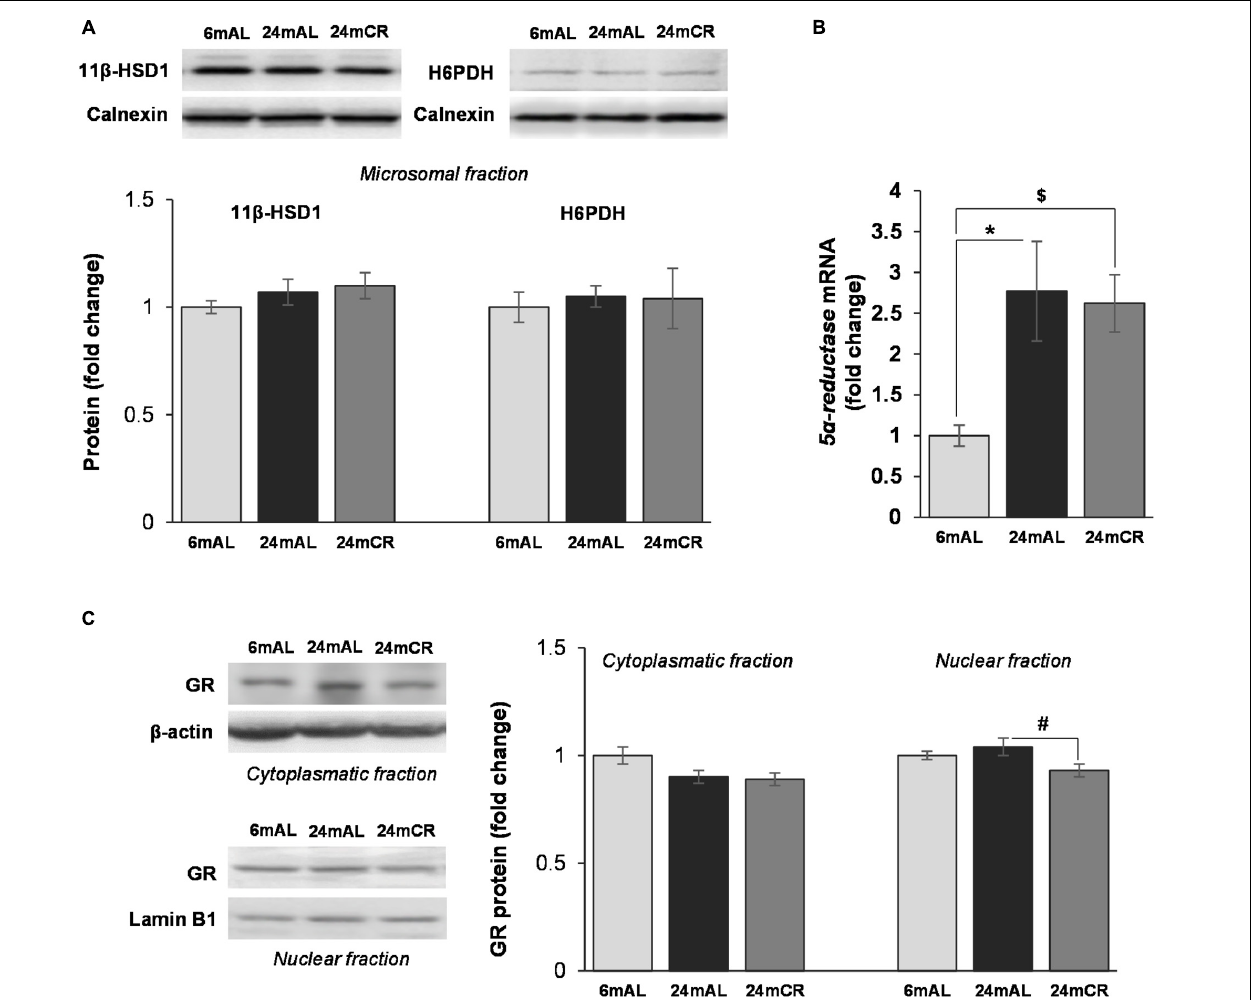
FIGURE 5 | Glucocorticoid prereceptor metabolism and GR protein level in the liver. Representative Western blots and relative quantification of 11 β -HSD1 and H6PDH protein levels in microsomal fraction (A) and GR protein levels in cytoplasmatic and nuclear fraction (C) of the liver of adults (6 mAL), aged rats on AL diet (24 mAL), and old rats on CR (24 mCR). Calnexin, β -actin and Lamin B1 were used as loading controls for microsomal, cytoplasmatic, and nuclear fraction, respectively. Quantification of 5 α -reductase mRNA (B) level in the liver was done relative to the amount of β -actin. All values are given as means ± SEM ( n = 8). Asterisk indicates significant difference between aged rats on AL diet and adults (24 mAL vs. 6 mAL, * p < 0.05) and symbol $ indicates a significant difference between old rats on CR and adults fed AL (24 mCR vs . 6 mAL, $ p <